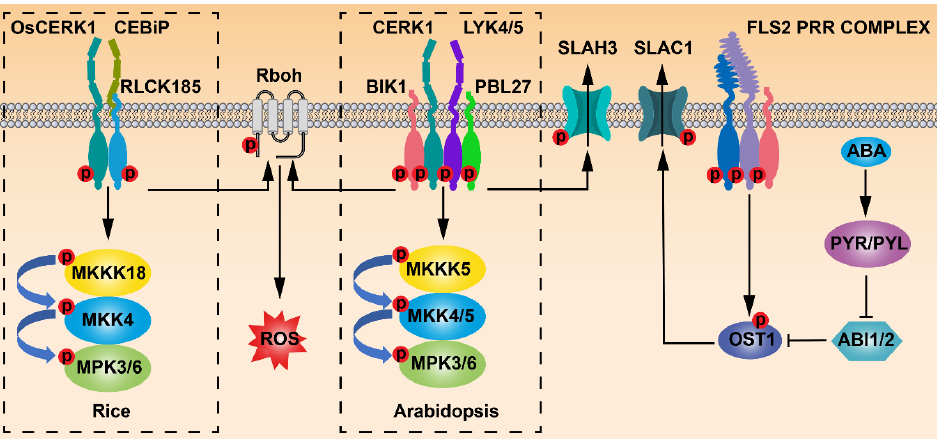
Figure 2. FLS2-mediated stomatal immunity. The FLS2 PRR complex plays a central role in Pst DC3000-triggered stomatal closure. FLS2 interacts with BAK1 and a receptor-like cytoplasmic ki- nase (RLCK) BOTRYTIS-INDUCED KINASE 1 (BIK1) to form a PRR complex in regulating stomatal immunity. BAK1 interacts with and phosphorylates OST1 to regulate ABA-induced stomatal clo- sure by activating an S-type anion channel SLOW ANION CHANNEL-ASSOCIATED 1 (SLAC1) and a K + channel in stomatal immunity. BIK1 interacts with and phosphorylates EXTRA-LARGE G PROTEINS (XLGs) to regulate RESPIRATORY BURST OXIDASE HOMOLOGUE D (RbohD)-medi- ated ROS production. BIK1 can also phosphorylate RbohD directly to control ROS production in stomatal immunity. The FLS2 PRR complex regulates stomatal closure through phosphorylating Ca 2+ -permeable channel OSCA1.3 by BIK1, increasing the channel activity of OSCA1.3. Salicylic acid (SA) accumulation is triggered by PRR and activates SLAC1 through NPR1-mediated signaling. The SA signaling can regulate ABA biosynthesis and positively modulate stomatal immunity.